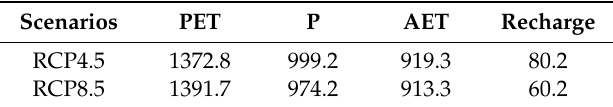
Table 3. Mean annual value (mm) of output parameters from Thornthwaite model. PET: Potential